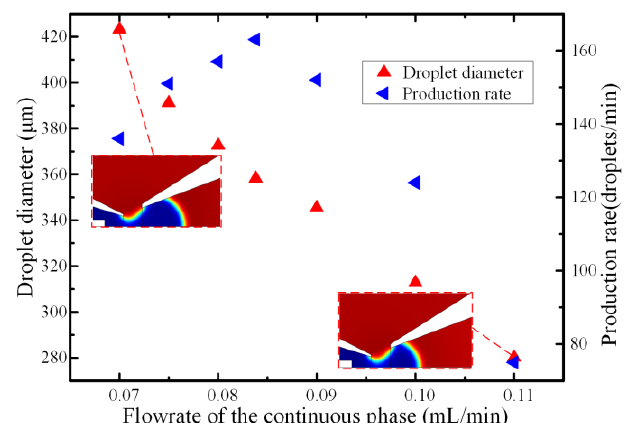
Figure 8. The effect of the flowrate of the continuous phase on the droplet diameter and generation frequency when the flowrate of dispersed phase and the viscosity of continuous phase were set as 10 μL/min and 0.044 Pa ·s, respectively.